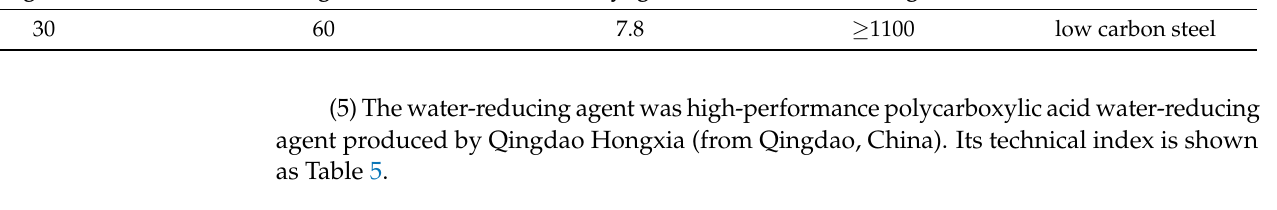
Table 5. Technical index of water-reducing